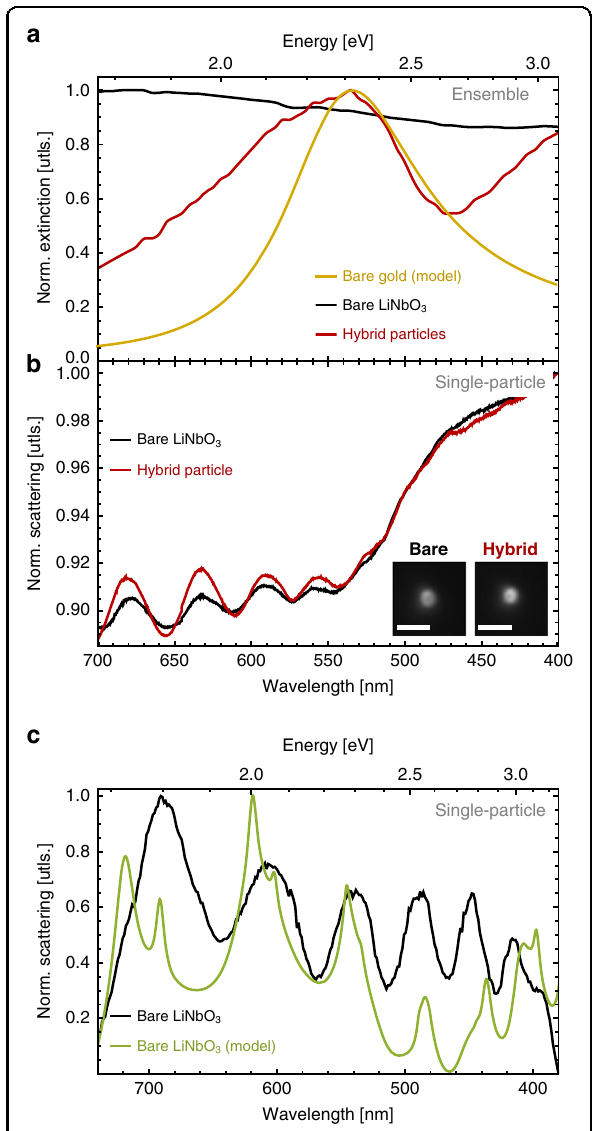
Fig. 3 Experimental and theoretical optical spectra. a Measured extinction spectra for ensembles of bare LiNbO 3 particles (black) and of hybrid Au – LiNbO 3 particles (red) compared to the modeled dipole plasmon extinction (gold). These spectra show a plasmonic peak at ~530 nm for the hybrid Au – LiNbO 3 particles, while the bare LiNbO 3 particles were optically transparent. b Light scattering spectra for individual bare LiNbO 3 particles and individual Au – LiNbO 3 hybrid particles measured in a dark fi eld (DF) con fi guration with white light illumination. The insets in ( b ) portray gray color images (scale bars = 2 μ m) for (black) a single LiNbO 3 particle and (red) a single Au – LiNbO 3 hybrid particle supported on glass coverslips. The data were normalized to the maximum value of the scattering intensity. c Theoretical scattering cross sections (green) from a model microsphere with dielectric constant 6.3 + 0.05 i and radius 700 nm in comparison with experimentally measured scattering data from a single, bare LiNbO 3 particle (black), normalized to range from 0 to 1 within the